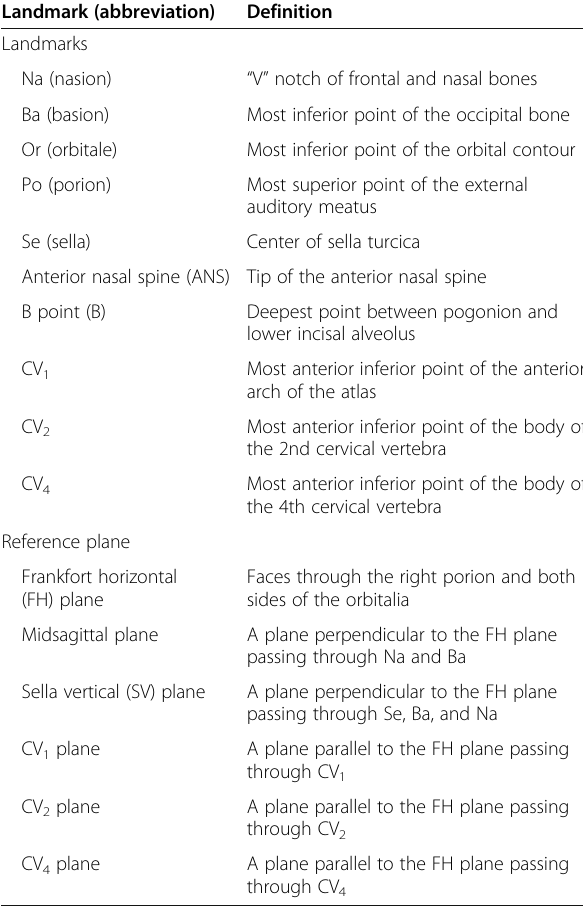
Table 2 The landmarks and the reference plane